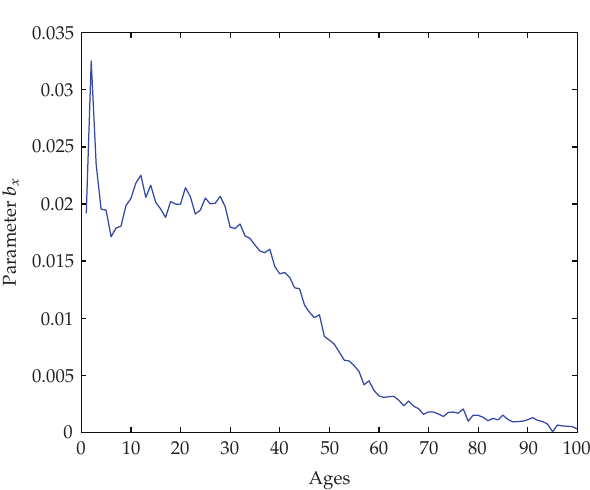
(cid:8) Figure 2: Parameter b x based on the Swedish male 1921–1960 mortality data.